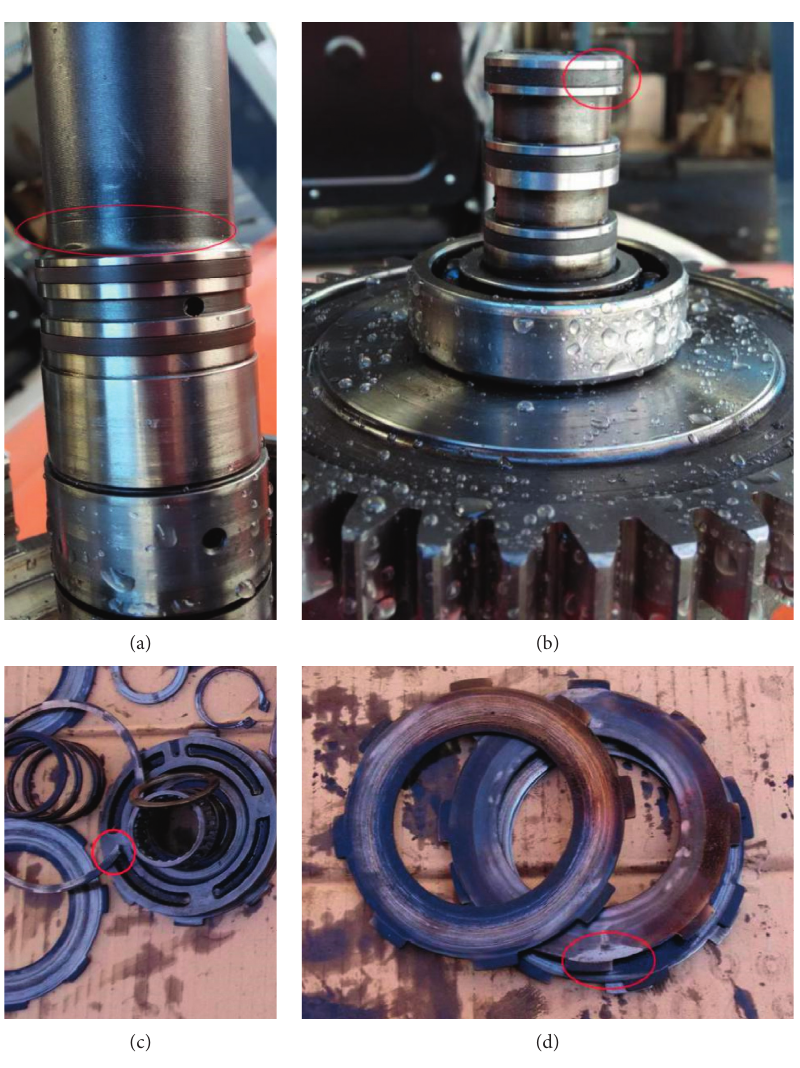
Figure 2: Partially failed